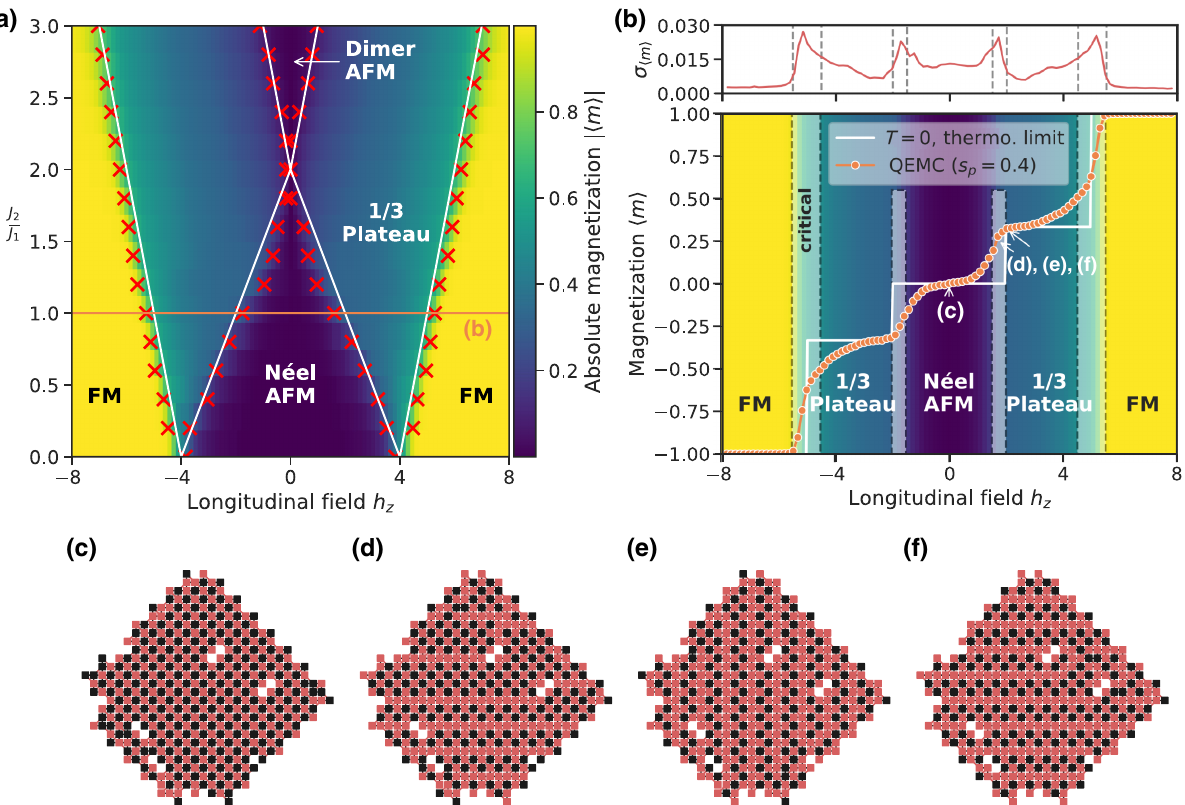
FIG. 3. Phase diagram and spin structures. (a) Phase diagram obtained by QEMC chains with t r = 1 μ s, t p = 1998 μ s, and s = 0.4. The simulated phase boundaries, shown with red crosses, are determined by calculating the point of steepest slope of magnetization. plateau, the dimer, FM, and the Néel states. The white lines outline the exact phase diagram as This helps to distinguish the 1 3 determined analytically by Dublenych [6]. A slice of the phase diagram at J 2 / J 1 = 1 is shown in (b). (b) Slice of phase diagram at ( J 1 = 1, J 2 = 1) obtained by QEMC chains with t r = 1 μ s, t p = 1998 μ s, and s = 0.4. The observed phase transition is broadened compared to exact results due to a number of compounding effects, the most notable being bond disorder of J 1 , J 2 , residual effects of point defects and finite lattice size, non-negligible persistent transverse field, and temperature effects. Each data point is the average of 100 QEMC chains, each of 100 iterations in which we sample the last 50, providing 5000 spin configurations per data point. We observe that the standard deviation of the magnetization, σ (cid:2) m (cid:3) , lies within the range 0.002 ≤ σ (cid:2) m (cid:3) < 0.03 and has characteristic peaks within the critical regimes. We find that σ (cid:2) m (cid:3) is sufficiently small that the round markers obscure the plotted error bars completely and so it is plotted above the magnetization for clarity. Four points are labeled (c)–(f) that correspond to the structures shown in panels (c)–(f). The critical regimes are highlighted in white. (c),(d) The real-space spin motifs determined by QEMC chains in the Néel AFM and critical AFM to plateau phase calculated at the points labeled in (b). In (d) we observe a coexistence between the Néel and plateau orderings separated by domain walls. (e),(f) Two degenerate solutions within the plateau phase. The black and red squares represent spin up and down,